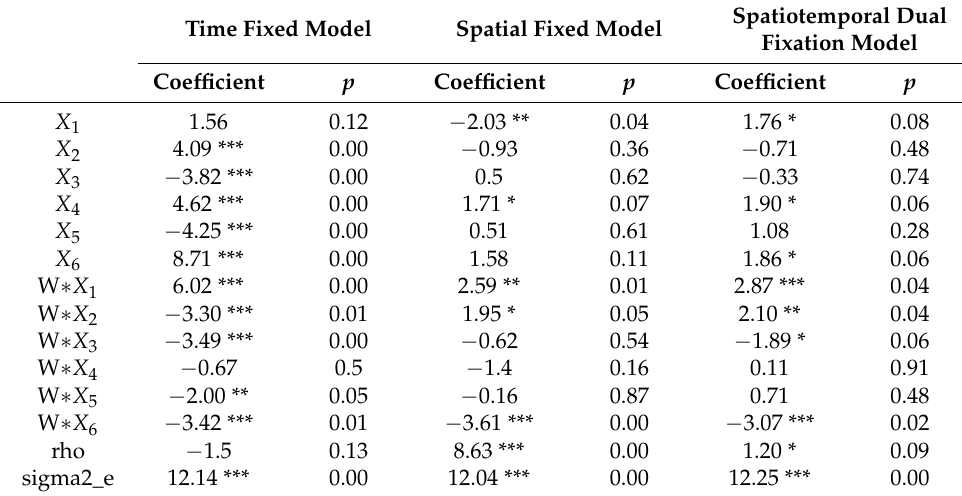
Table 11. SDM model estimation results under different